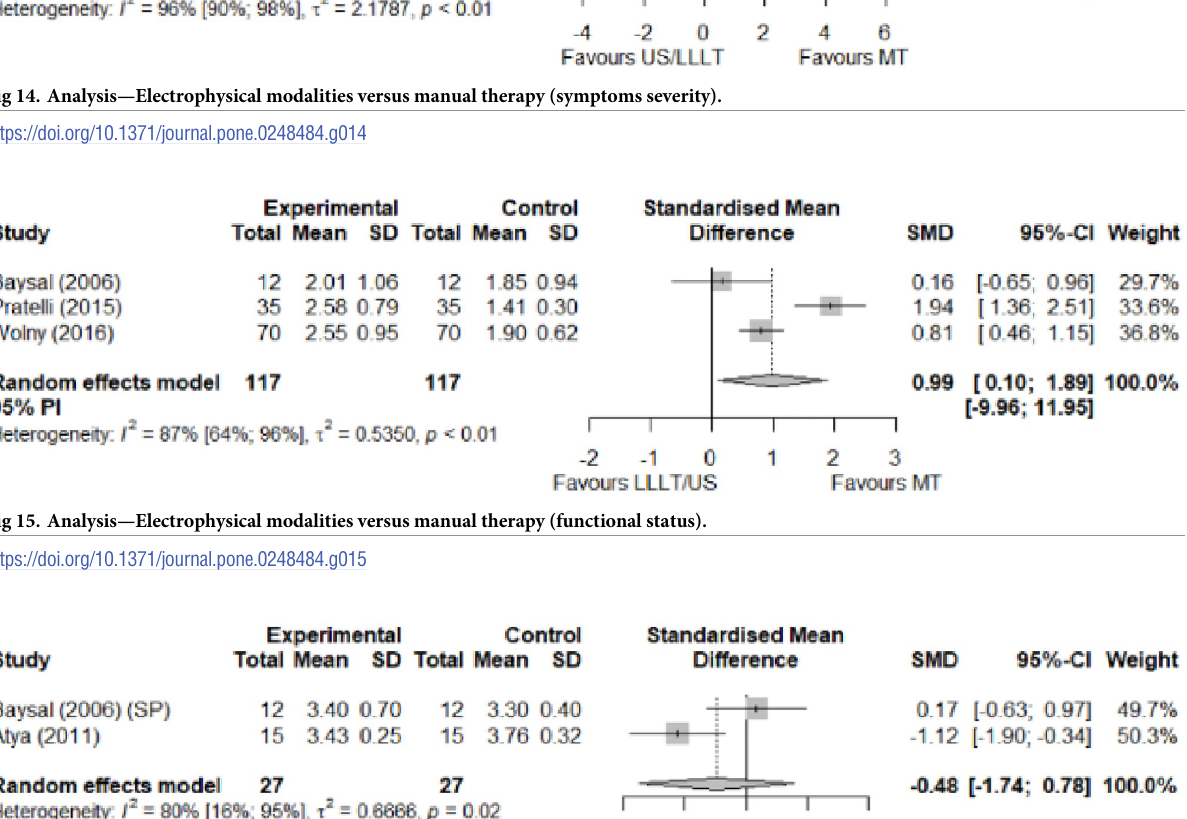
PLOS ONE | https://doi.org/10.1371/journal.pone.0248484 March 18, 2021 12 /